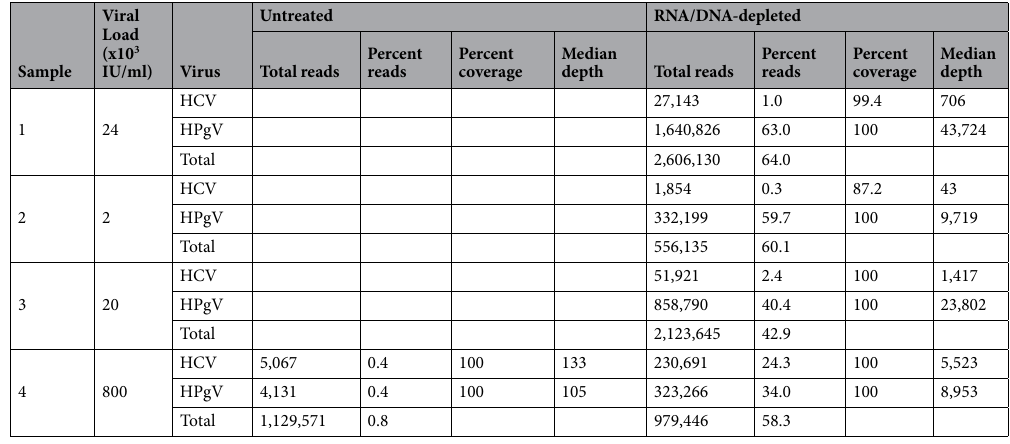
Table 5. Detailed sequencing data from the patient sample series. For each of the four samples 1–4, the number and percentage of reads mapping to both the HCV and HPgV genomes are given, genome coverages (depth ≥ 10) and median depths. The analysis of sample 4 extracted without host rRNA depletion is in the Untreated column.